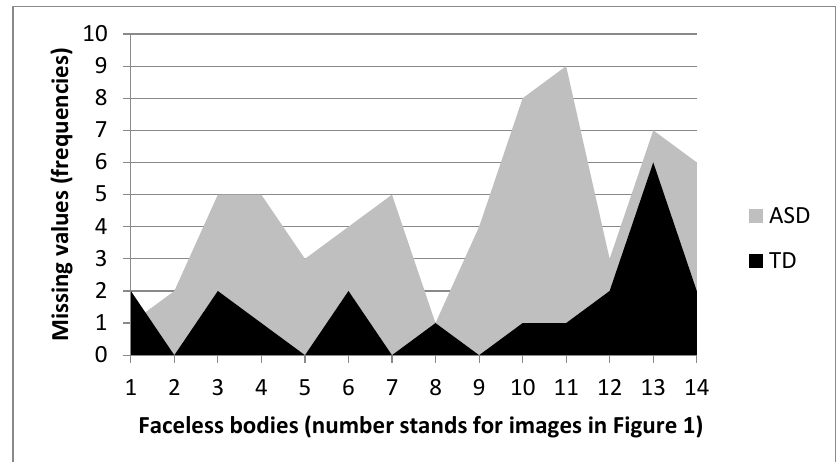
Figure 7. Frequencies of missing values for headless bodies for ASD and TD.